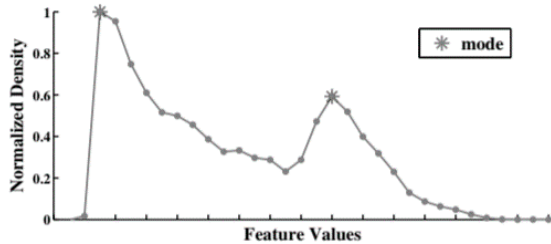
Figure 4. Probabilistic density function estimated by kde [13].